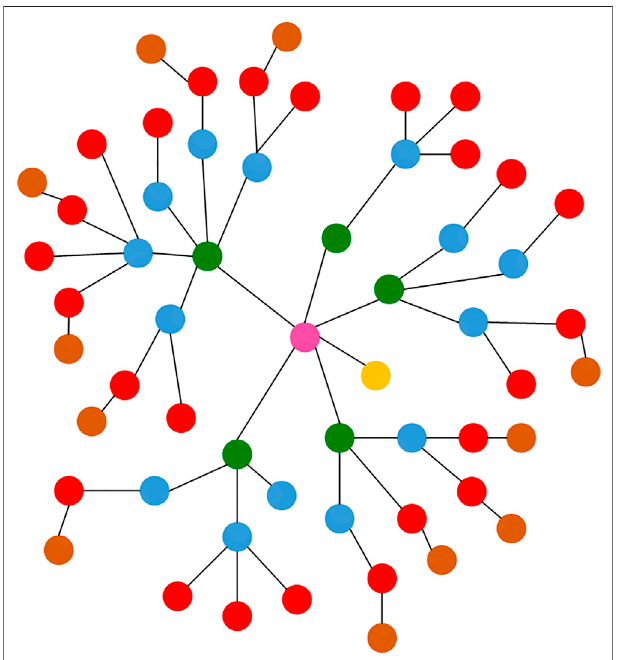
FIGURE 3 | Transformer knowledge graph (part).